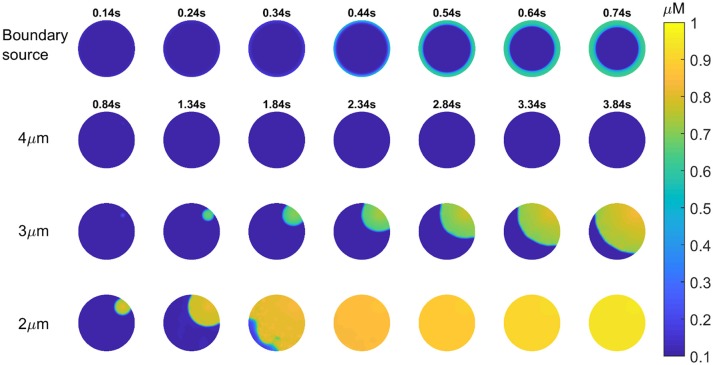
Simulation of InsP3 induced Ca2+ release in eggs. Images are shown for a 2-dimensional simulation of the propagation of a Ca2+ wave in a mouse egg using a mechanism based upon Ca2+ induced InsP3 formation. Images for each time series is shown in each of the rows. For the first row the only source of PIP2 for making InsP3 is at the boundary (the plasma membrane) and this does not cause a wave at all. The times for each image (in seconds) in the top row is indicated by numbers above each image. In the next three rows the source of Ca2+ induced InsP3 formation is spaced at different distances. The time intervals for each image is indicated in the second row and it is then the same for each image going down in each column. In the first row the distance for the PIP2 is 4 μm, and again no Ca2+ wave can be generated. With a PIP2 source spaced at 3 or 2 μm we found that a Ca2+ wave can be generated. With a 2 μm separation a wave occurs that crosses the “egg” in ~1 s.